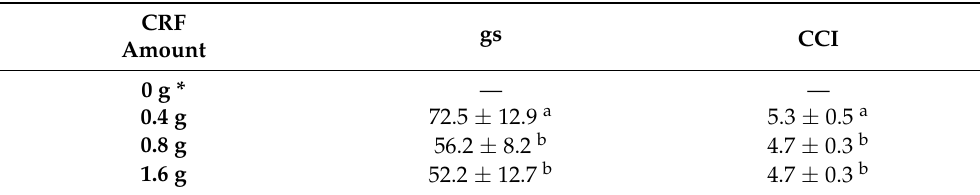
Table 6. Effect of different concentration of CRF on stomatal conductance (g s ) and chlorophyll content index (CCI).